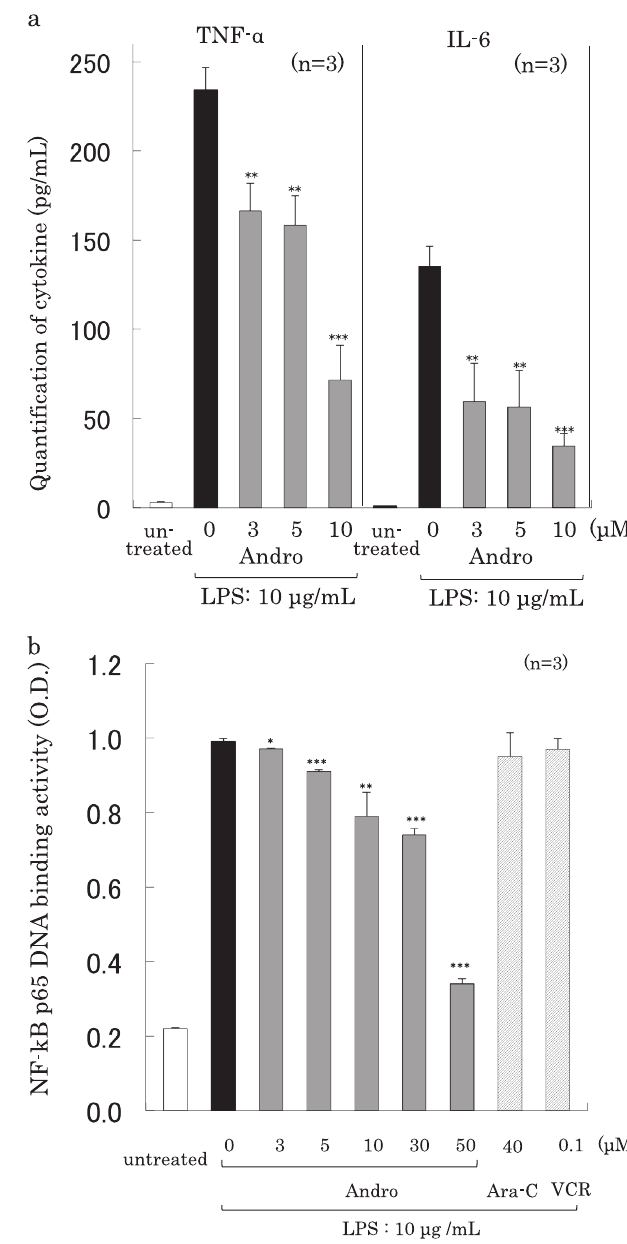
Figure 6 Effects of Andro on the inflammatory cytokine levels stimulated by